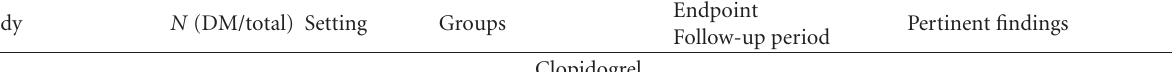
Table 1: A summary of key antiplatelet drug clinical trials in patients with diabetes